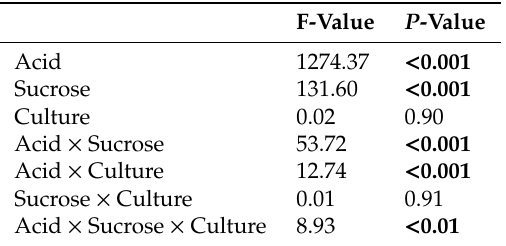
Table 5. F- and p -values for mixed model Analysis of Variance for Sourness Intensity. Significant effects ( p ≤ 0.05) are marked in bold.